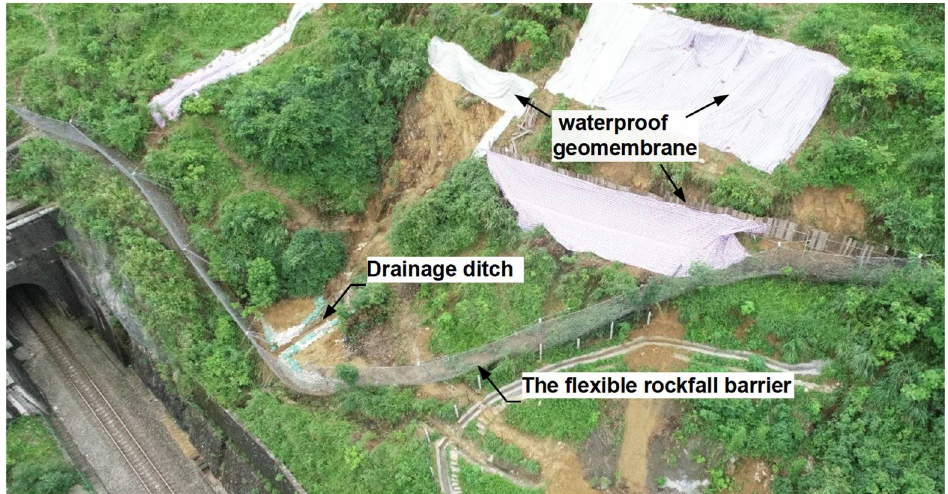
Figure 5. An overall view of the landslide site after maintenance.